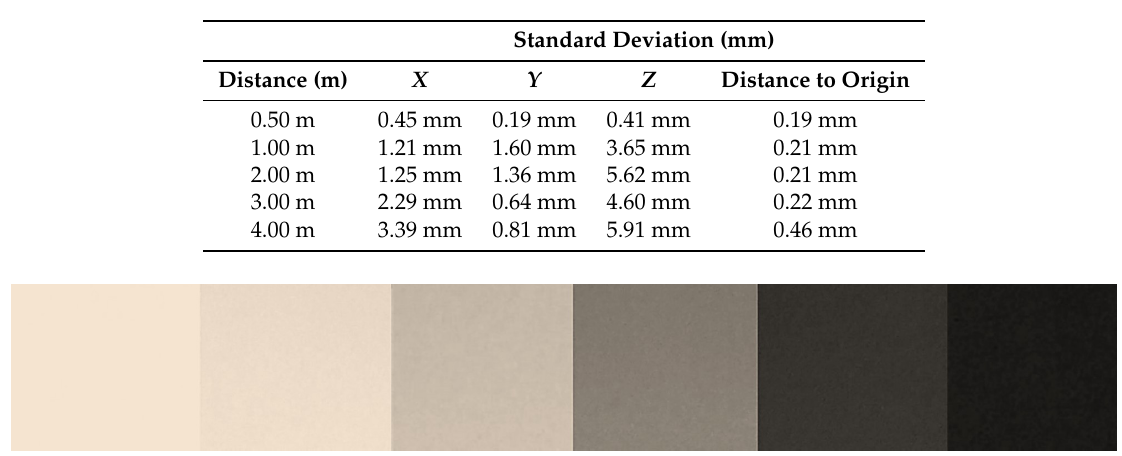
Table 1. Standard deviation of target boards at varying distances on three axes.